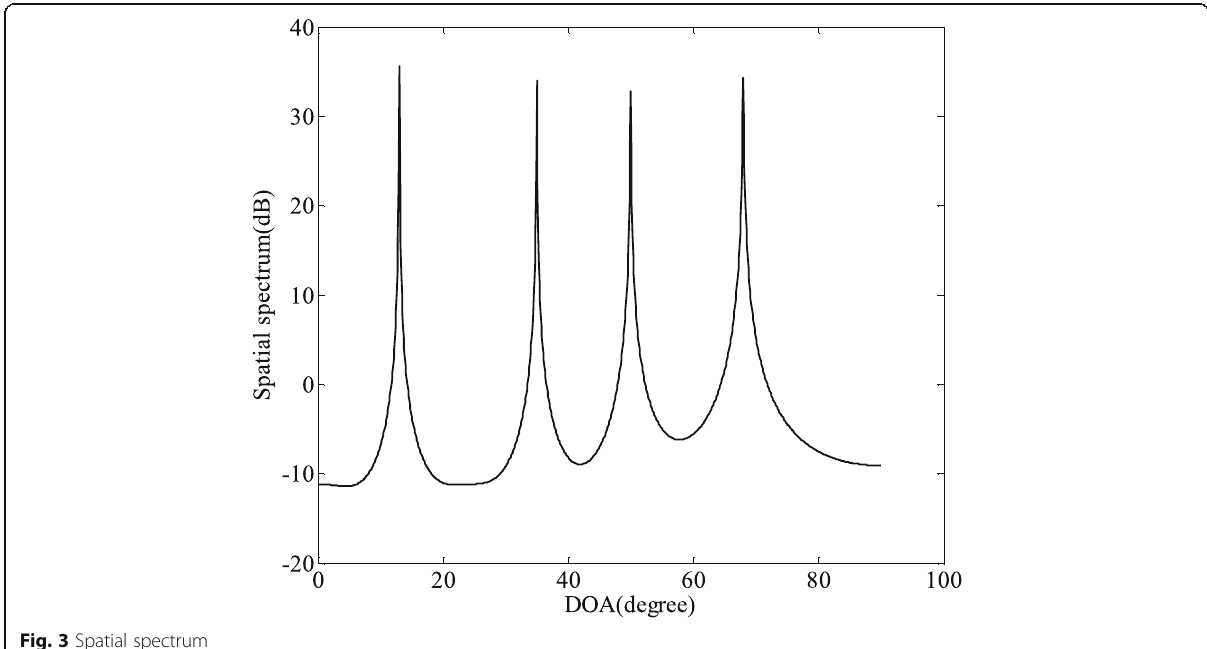
Fig. 3 Spatial spectrum